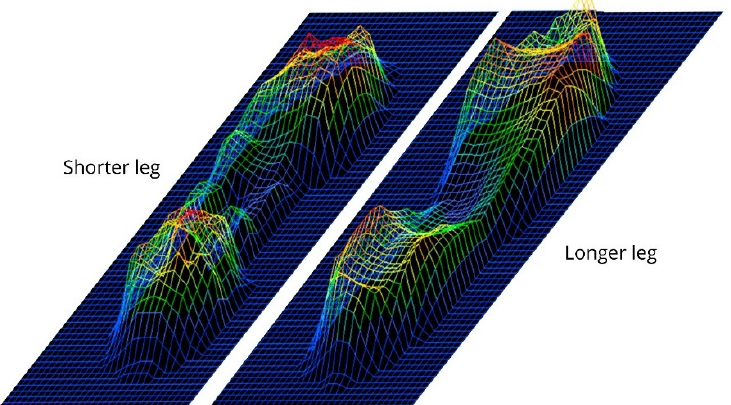
Figure 1. An example of the plantar pressure curves of one subject during gait with a simulated LLD (20 mm).